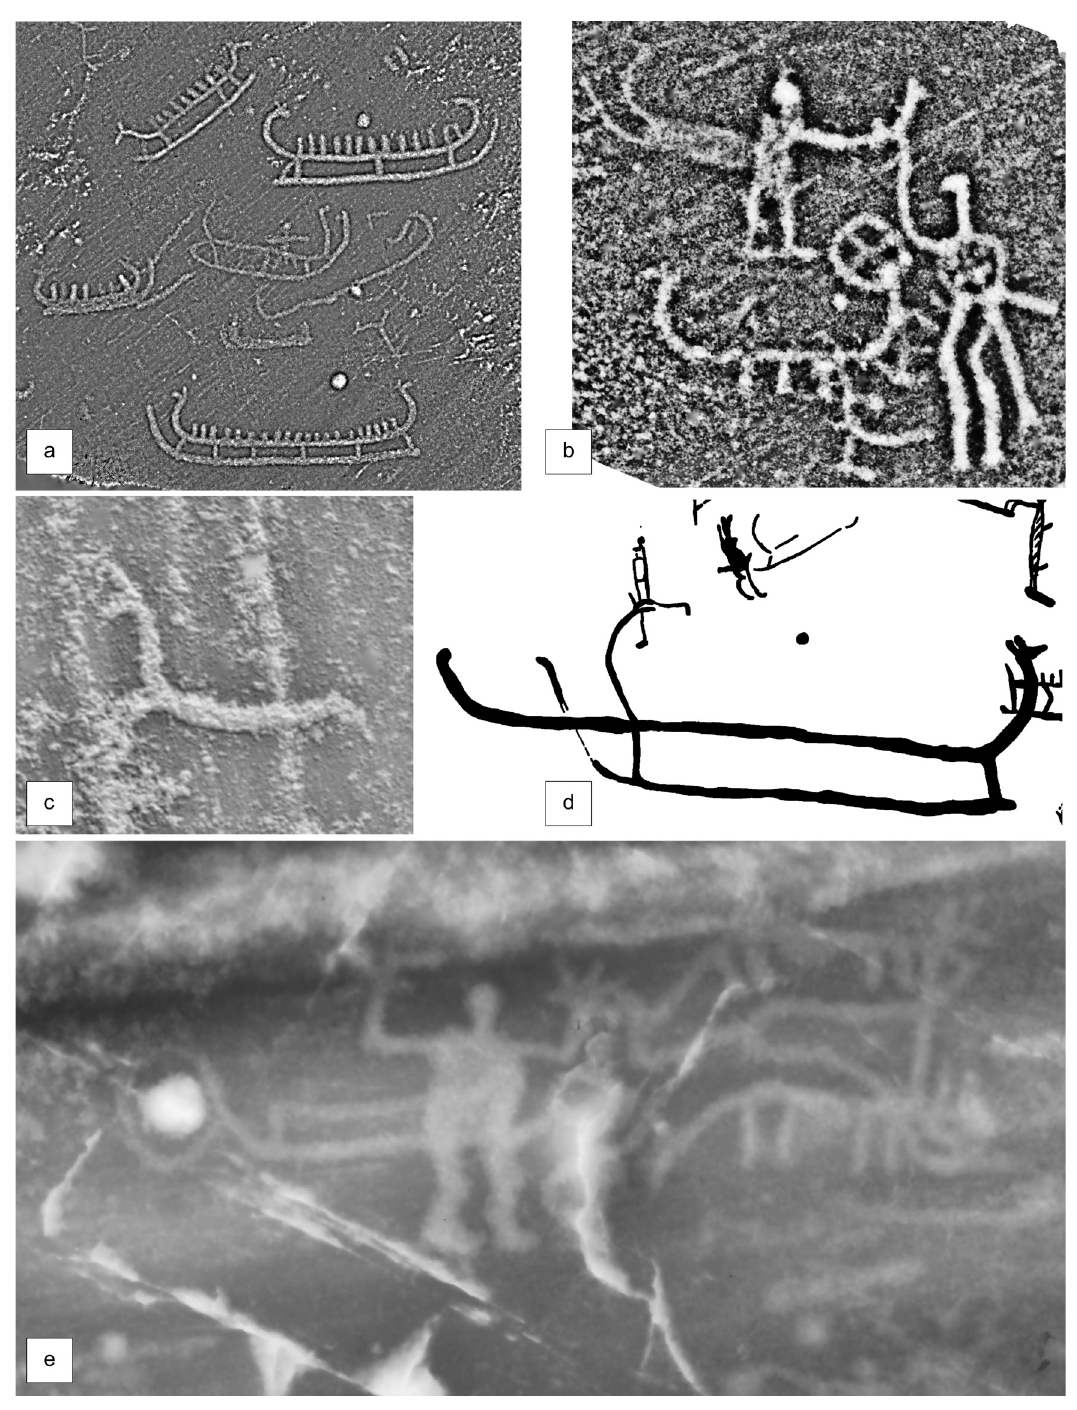
Figure 1: Examples of the ambiguity present in Nordic Bronze Age rock art: ( a ) boats with animal ( horse ) heads as prows in Brastad ( 5:1 ) ; ( b ) a human with a prow - like arm and at the centre an animal - boat hybrid on Aspeberget ( Tanum 12:1 ) ; ( c ) a partial horse as comparison for the animal prow - heads in Litsleby ( Tanum 72:1 ) ; ( d ) boat with an animal head prow and the left prow superimposes a human - boat hybrid in Vitlycke ( Tanum 1:1 ) ; and ( e ) a boat superimposes a human fi gure so that the stem of the boat also depicts the human ’ s phallus in Bottna ( 74:1 ) . All images with the exception of visualizations of 3D models ( Horn et al., 2019, 2022 ) . Image ( e ) is an interpretation after a 3D documentation. Documentation ( a ) and ( d ) by Rich Potter and Christian Horn ( GU ) ; ( b ) and ( c ) by Henrik Zedig ( County Administrative Board in West Sweden ) ; and ( e ) by Ellen Meijer ( SHFA )